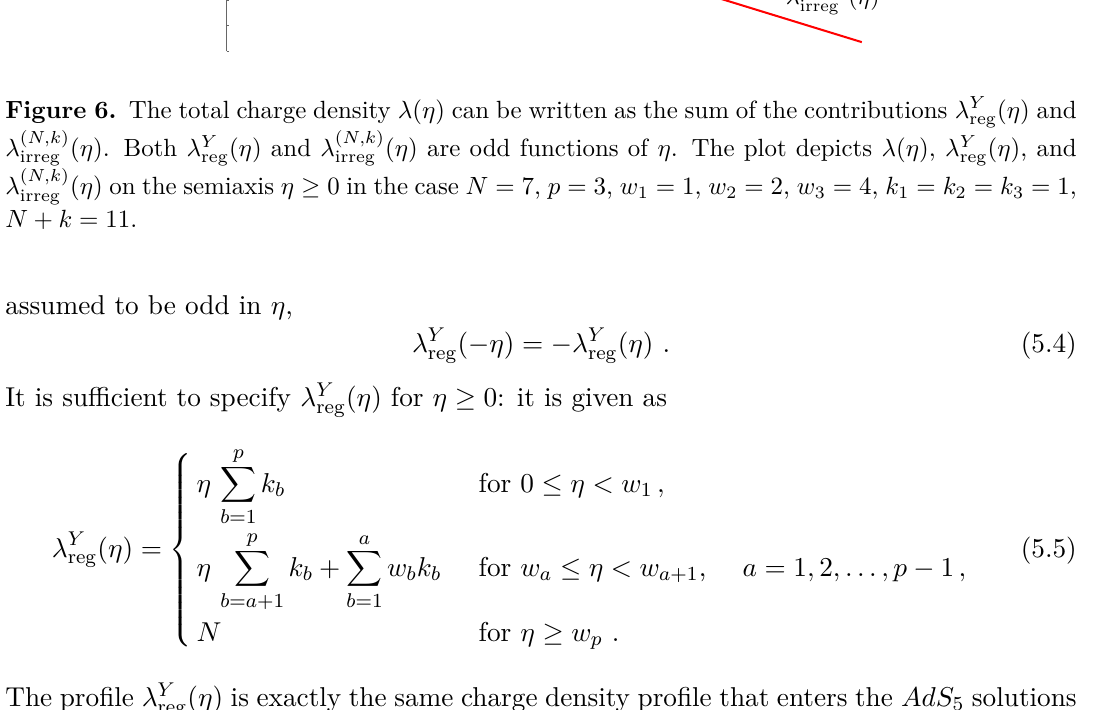
( η ) and λ ( N,k ) ( η ) are odd functions of η . The plot depicts λ ( η ) , λ Y reg irreg